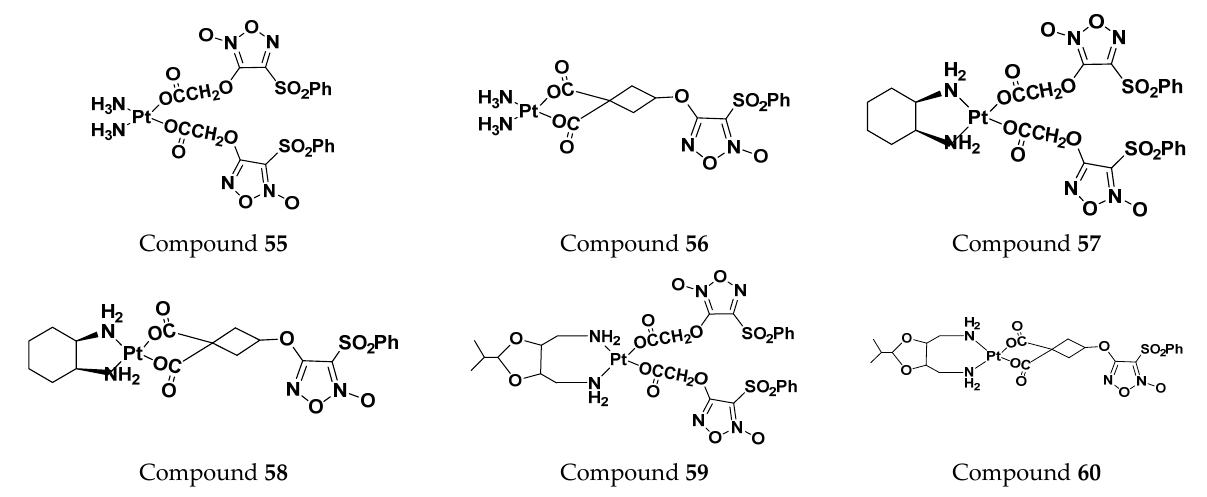
Figure 63. Platinum hybrid derivatives ( 55 – 60 ). Table 50. In vitro cytotoxic activities of Platinum hybrid compounds ( 55 – 60 ).